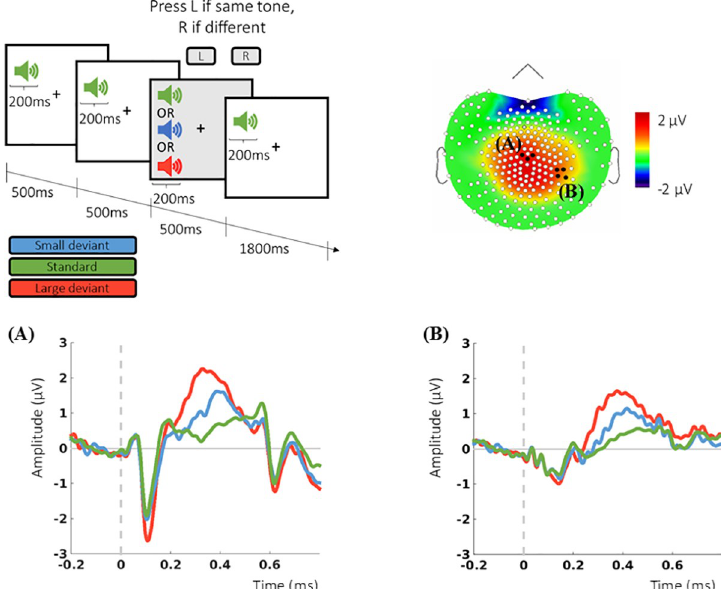
Fig 2. Oddball task and evoked potentials. Upper panel shows an example trial of the multiple auditory oddball task and the grand average topographic maps for the P300 with the 2 clusters of electrodes used for analysis highlighted (A and B). Participants completed 260 trials, each consisting of a sequence of four 200-milliseconds long tones presented binaurally at 70dB. The first, second and last tone of each of the trials were always “standard” tones (1047 Hz), the third tone could be either a standard tone or one of two deviant tones; a “small deviant” tone (1078 Hz) or a “large deviant” tone (1175 Hz). Participants were instructed to fixate a cross in the middle of the computer screen, and to report whether the third tone of each of the series was the same (right button press) or different (left button press) from the other three tones. Of the 260 trials, 146 (about 56% of all trials) were standard trials, 57 were small-deviant trials and 57 were large-deviant trials (each about 22% of all trials), presented in random order. (A) Grand average over the electrode cluster surrounding Cz and (B) over a cluster chosen following a data-driven approach.